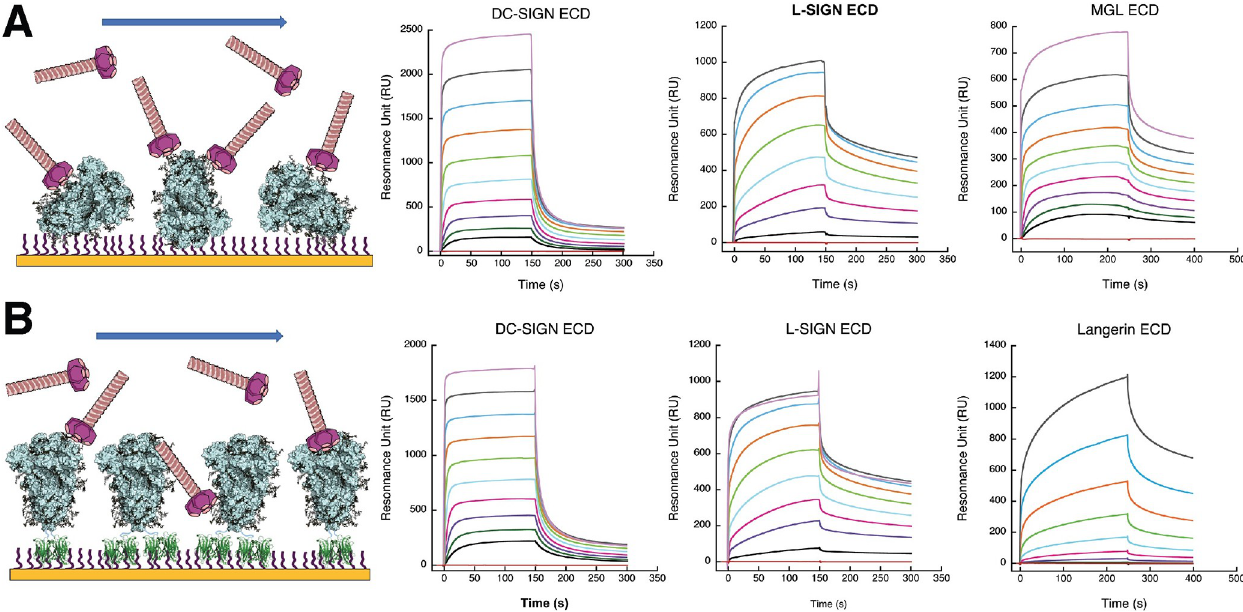
Fig 2. CLRs interaction with SARS-CoV-2 S protein. (A) Covalently functionalized S protein surface in random orientation. Multivalent CLRs oligomeric ectodomains (ECDs) are injected over the surface. From left to right, surfaces titrations were performed with ECDs of DC-SIGN, L-SIGN and MGL. ( B) Oriented surface set-up. Surfaces were first functionalized with streptactin (in green) and then S protein was captured by its C-terminal double-StrepTagII. From left to right, surfaces titrations were performed with ECDs of DC-SIGN, L-SIGN and Langerin. The same color code for concentrations of all CLR-ECDs has been used for all panels. Concentrations injected (i.e. DC-SIGN ECD in A) range from 50 μ M to 0.1 μ M by 2-fold serial dilutions (decreasing concentrations from top to bottom). The red sensorgram, lower flat line, corresponds to control experiments with buffer injection with no CLR.